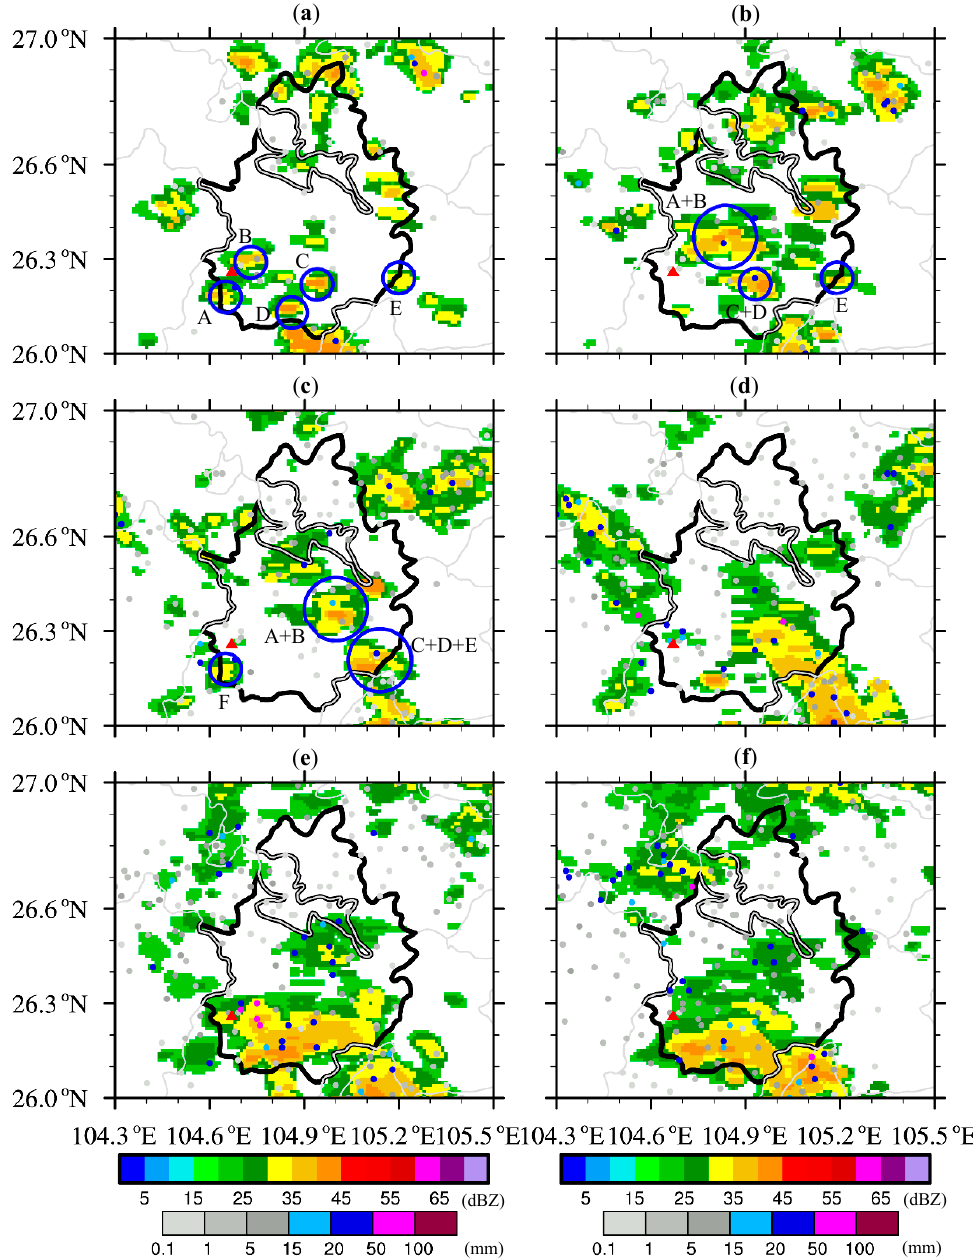
Figure 5. Radar maximum composite reflectivity of three-dimensional mosaic data (shaded, dBZ) overlaid by 1 h accumulated rainfall (colored dots, mm) near Shuicheng County ( a ) from 09:00 to 10:00 UTC; ( b ) from 10:00 to 11:00 UTC; ( c ) from 11:00 to 12:00 UTC; ( d ) from 12:00 to 13:00 UTC; ( e ) from 13:00 to 14:00 UTC; ( f ) from 14:00 to 15:00 UTC on 22 July 2019. The letters in the panels represent the convective cells referenced in the main text.